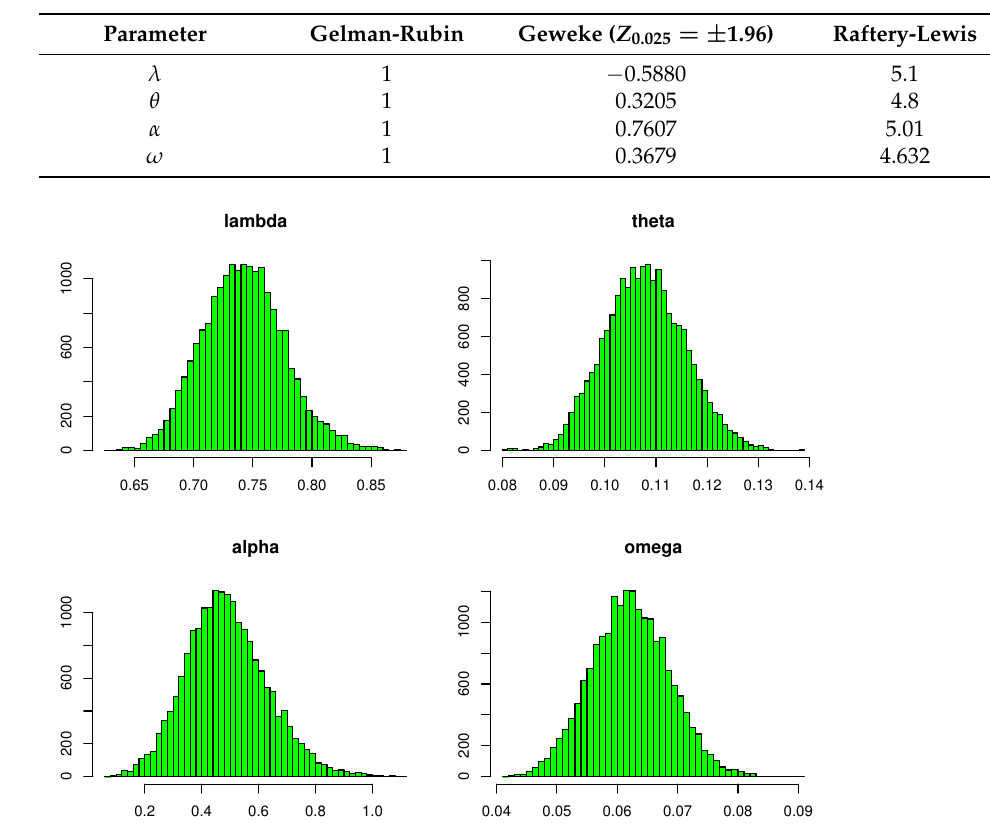
Figure 8. Plots of Bayesian analysis and performance of Gibbs sampling for DS1 dataset. Histogram plots of each CWE distribution parameter.